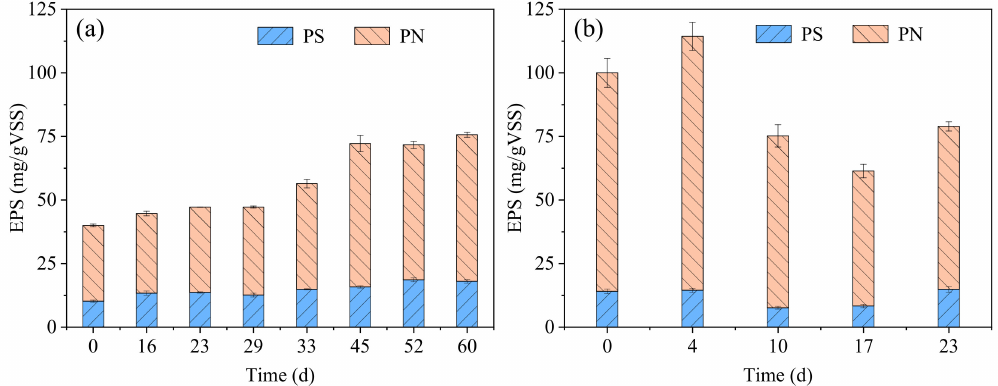
Figure 3. Changes in sludge EPS content (PN and PS) in R1 ( a ) and R2 ( b